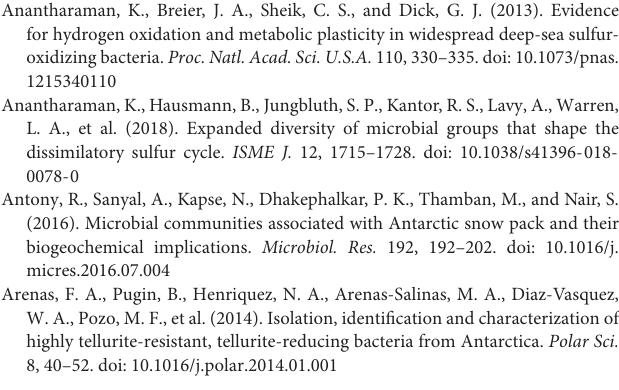
FIGURE S1 | Overview of the Antarctic continent showing the major geographic regions. Ice-free areas are highlighted in brown (modified from map no. 13.766 of the Australian Antarctic Data Centre, 2010). TABLE S1 | Names of phylum/superphylum level groups a in different sequence databases b . TABLE S2 | List of valid prokaryotic species that have been described with a type strain originating from Antarctica, listed alphabetically per phylum. Genera first described from Antarctica are marked with a ∗ . Genera recovered during isolation campaigns involving Antarctic soil are marked with a †